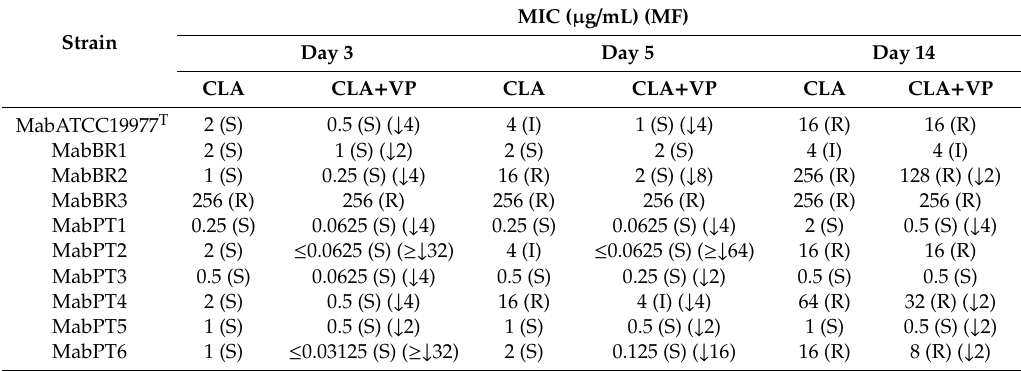
Table 3. Minimum inhibitory concentration and modulation factor of clarithromycin in the presence of verapamil for the M. abscessus strains in